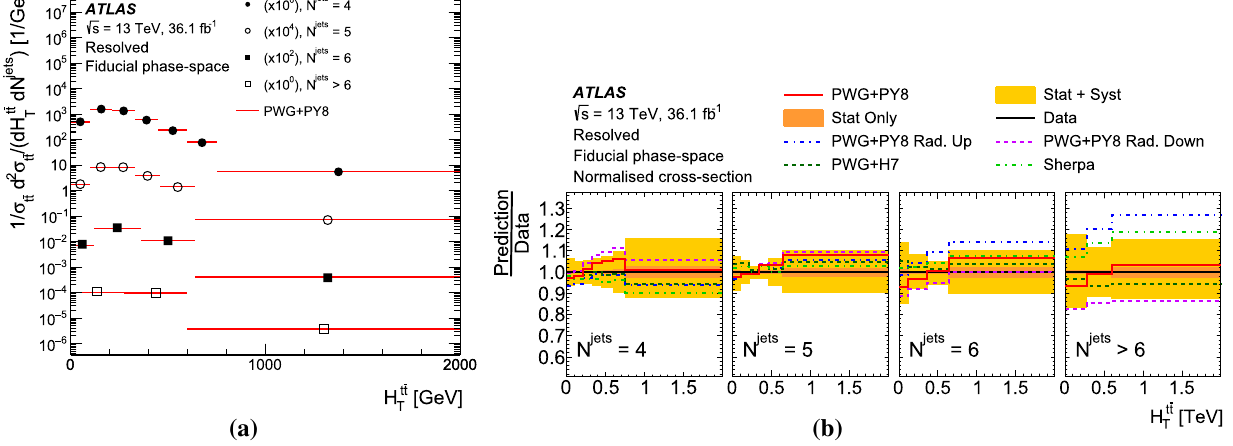
Fig. 35 a Particle-levelnormaliseddifferentialcross-sectionasafunc- tion of H t ¯ t in bins of the jet multiplicity in the resolved topology com- T pared with the prediction obtained with the Powheg + Pythia8 MC